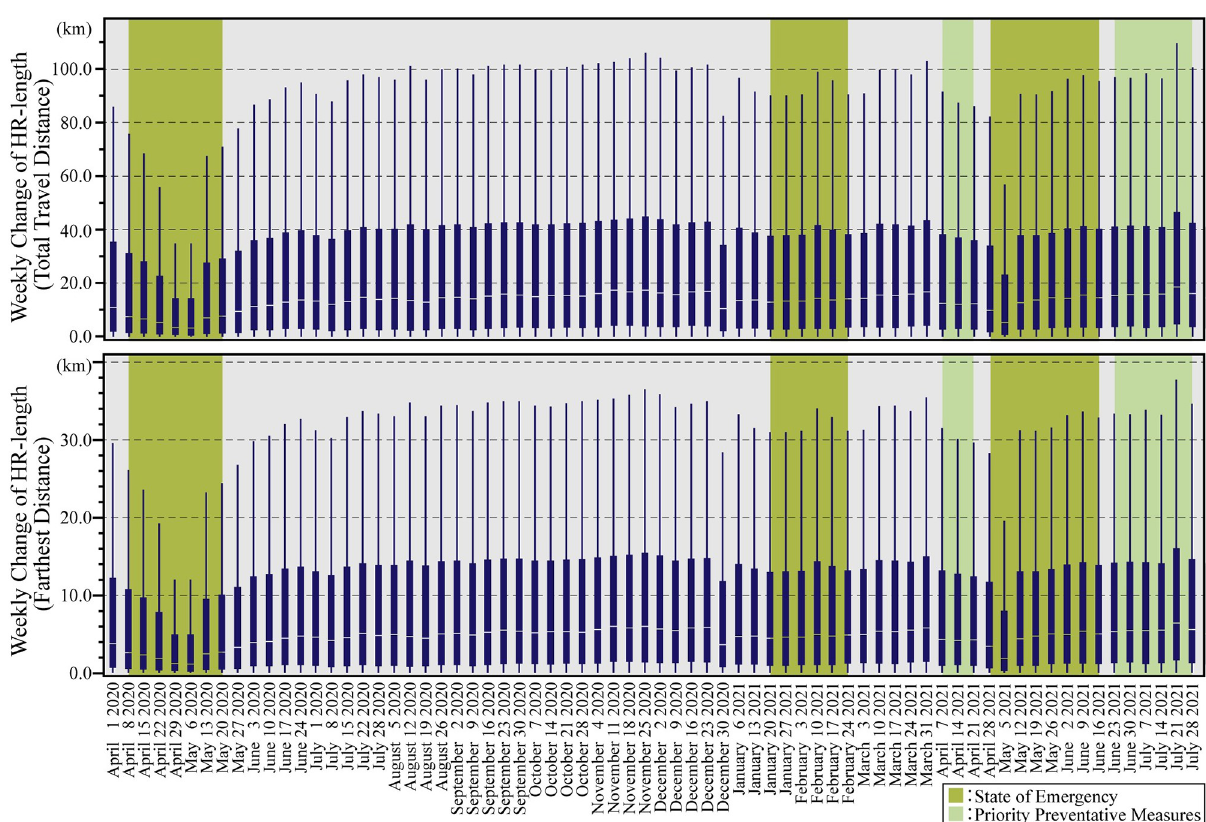
Fig 3. Weekly change of HR-length. The upper graph shows the weekly changes in HR-length (Farthest Distance). The lower graph shows the weekly changes in HR-length (Total Travel Distance). Green periods are during the state of emergency, and yellow-green periods are during the priority prevention measures. The box-plot diagrams do not depict the